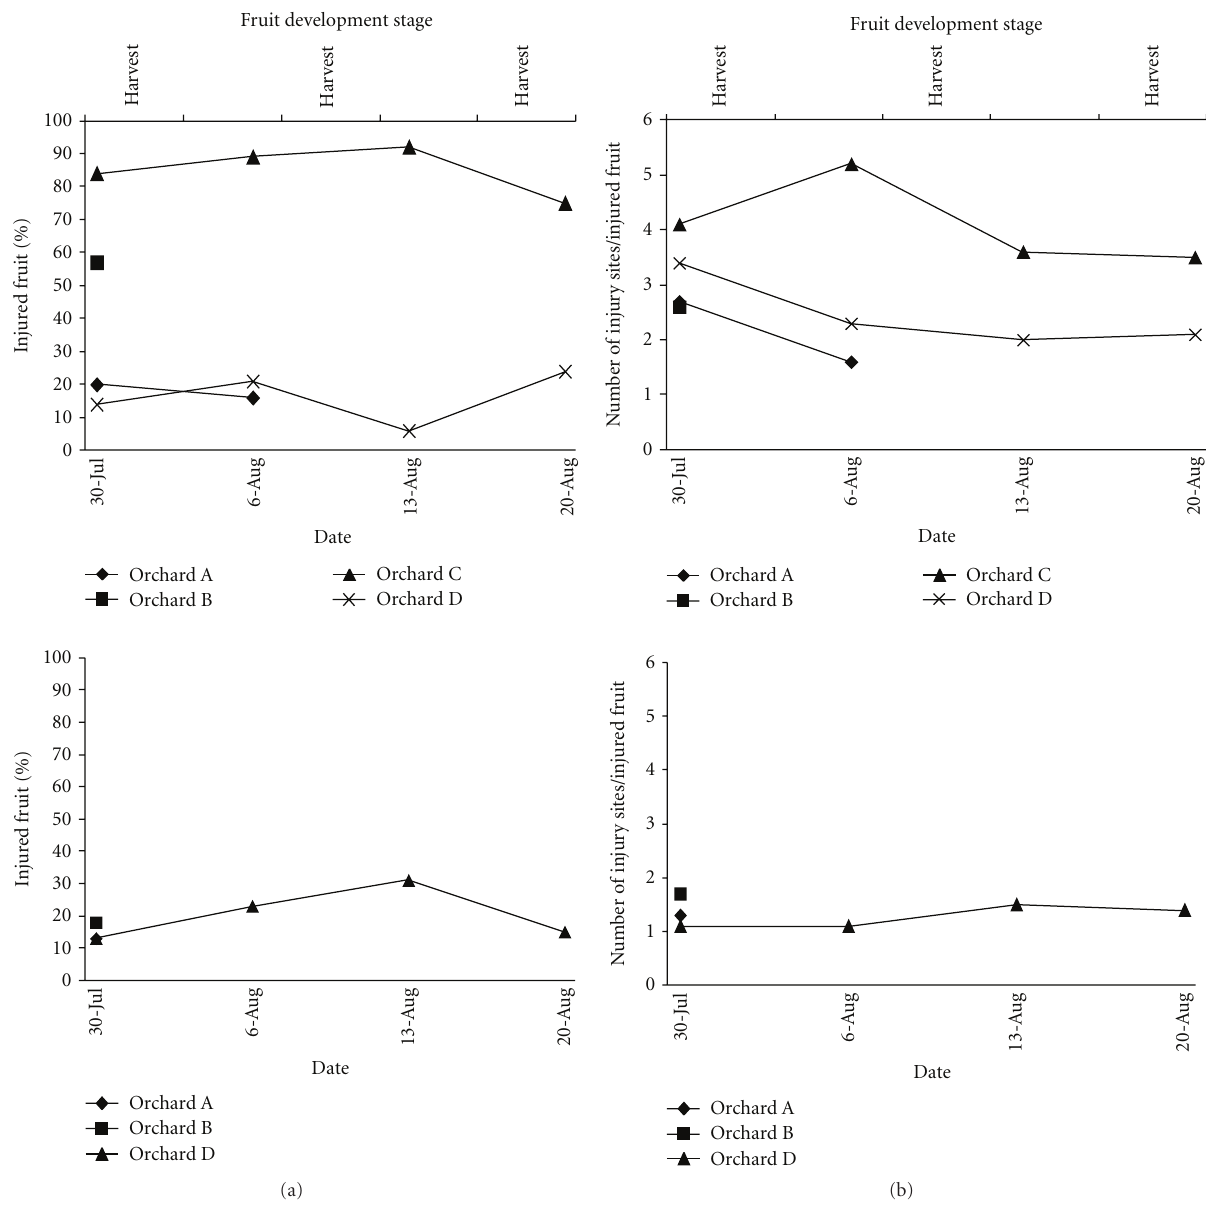
Figure 7: (a) Percent injured peaches in 2010 at orchards A–D from the plot exterior (top) and interior (bottom) and (b) the number of injury sites per injured fruit in 2010 at orchards A–D in the plot exterior (top) and interior